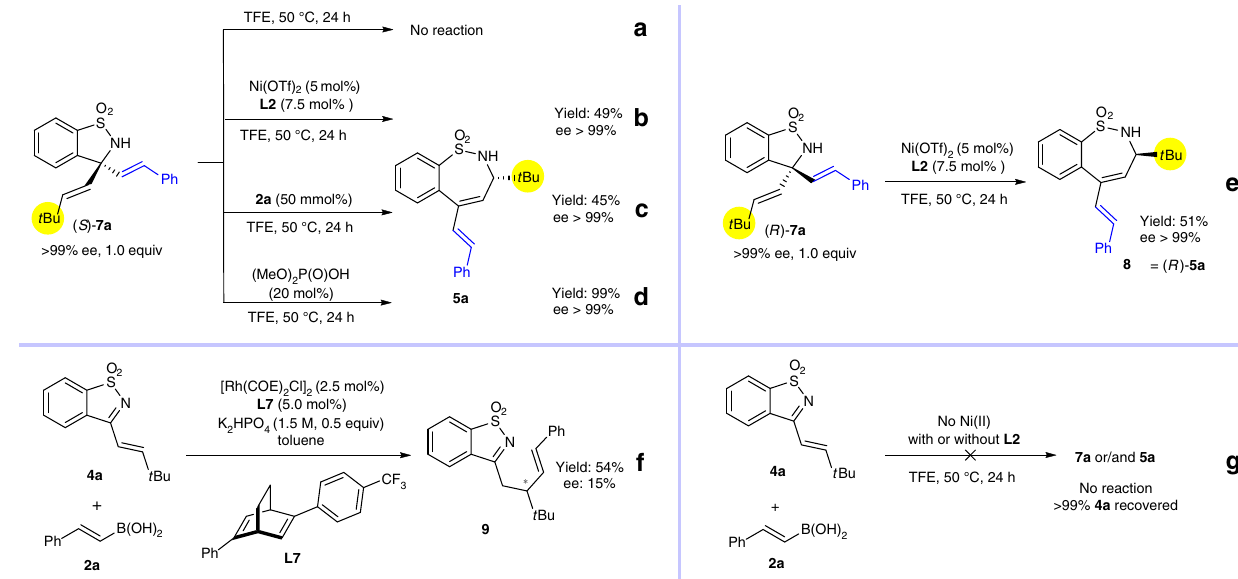
Fig. 3 Control experiments. These experiments indicate that the ring expansion step is an acid-promoted stereospeci fi c process